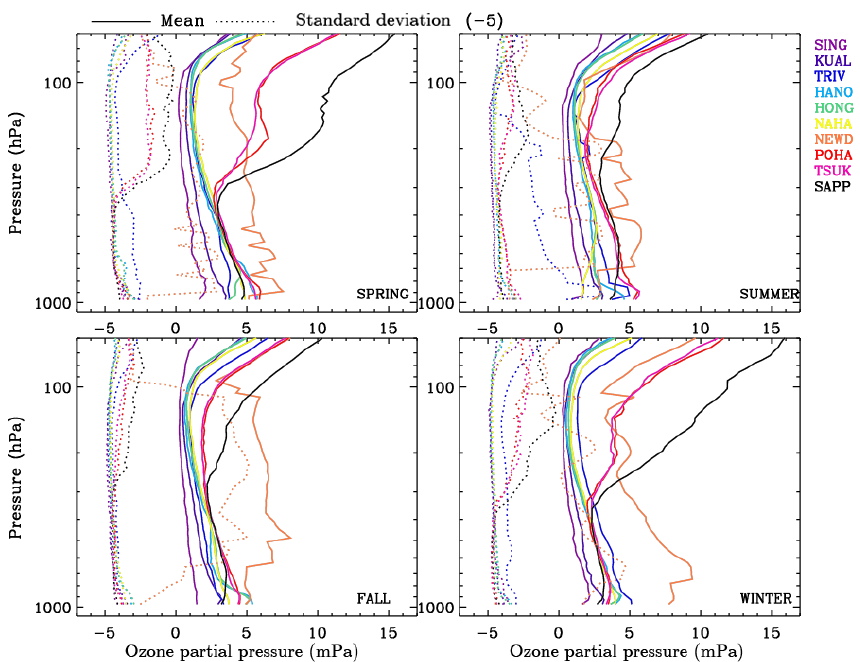
Figure 3. Seasonal mean (solid) and standard deviation (dashed) profiles of ozonesonde soundings from 2005 to 2015 at the 10 sites listed in Table 1; 5mPa is subtracted from standard deviations to fit the x